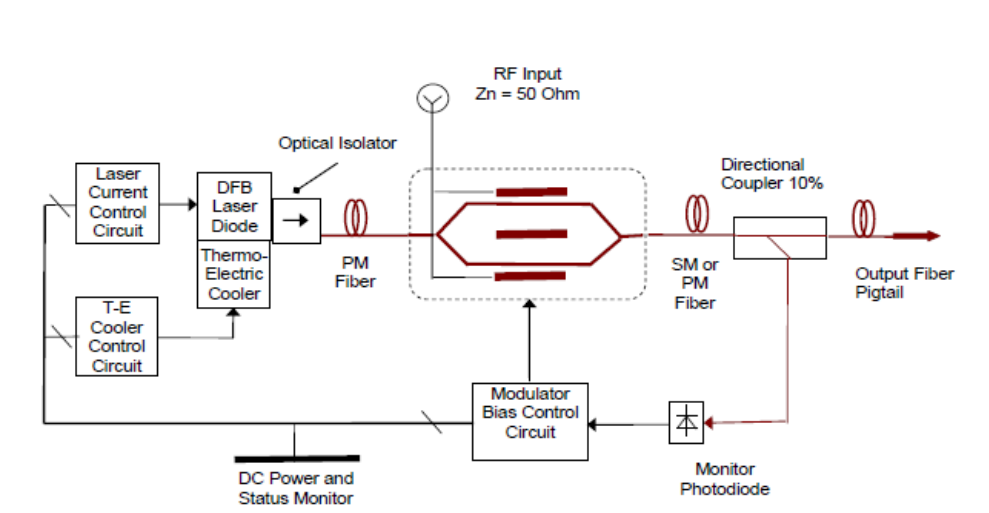
Fig. 3. Block diagram of the formation of an optical signal with analogue microwave modulation in intensity based on a DFB laser and an external Mach-Zehnder modulator for an onboard fiber optic link. of the dispersion coefficient D at a wavelength of light in vacuum  = с/ f , where хр с ≈ 3  10 9 m / s is the speed of light. Distinguish [4] its waveguide D and material D wave